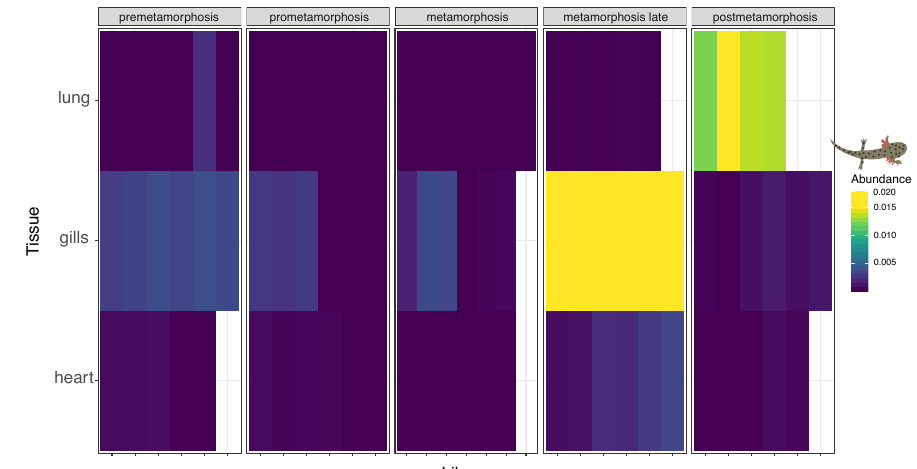
Figure 4. Heat map of the abundance of salamander influenza-like virus reads in the multi-tissue transcriptome library of developmental stages of plateau tiger salamander [44]. Read abundance for this virus was highest in the gills of late metamorphosis salamanders, and lungs of post metamorphosis salamander, strongly suggesting tropism for respiratory